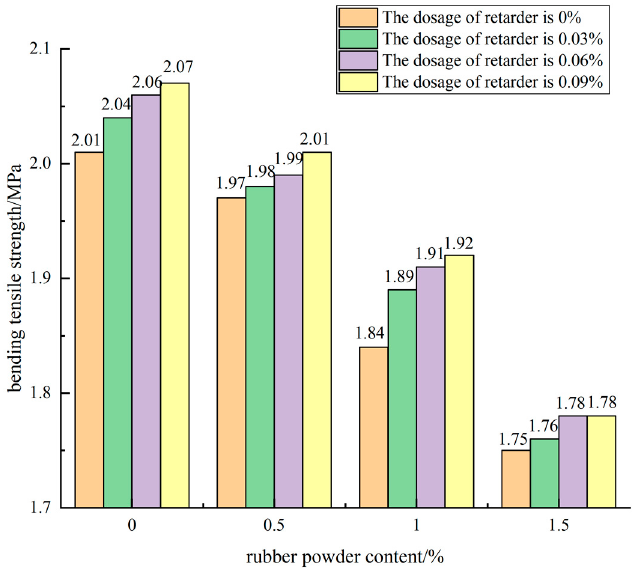
Figure 15. Effect curve of rubber powder content on flexural tensile strength.